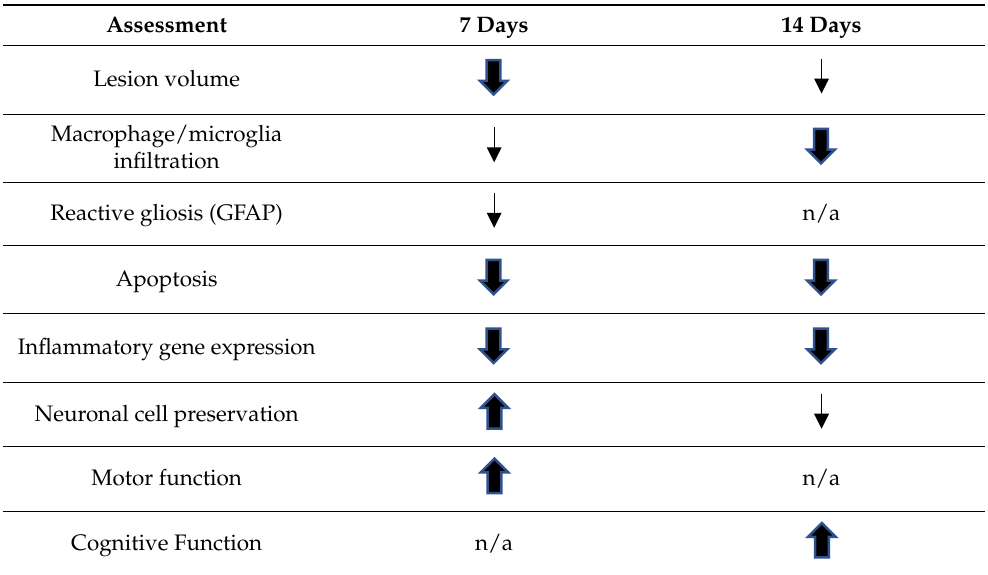
Table 1. Summary of key findings on the effect of PEG-bis-AA/HA-DXM hydrogel treatment from our previous study at 7 DPI [24] and the current study at 14 DPI.